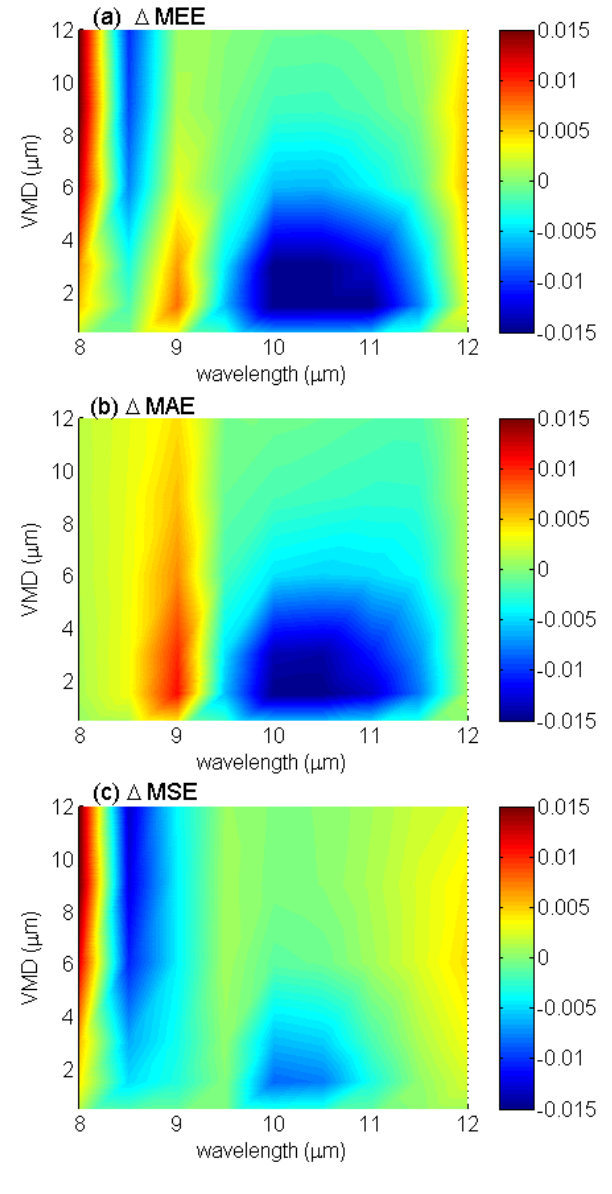
Figure 9 sensitivity of MEE to a clay-hematite mixture. Difference plots are shown for Fig. 9. Sensitivity of MEE to a clay-hematite mixture. Difference (a)  MEE, (b)  MAE, and (c)  MSE. All units are in m 2 g -1 . See text for details. plots are shown for (a) 1 MEE, (b) 1 MAE, and (c) 1 MSE. All units are in m 2 g − 1 . See text for details.